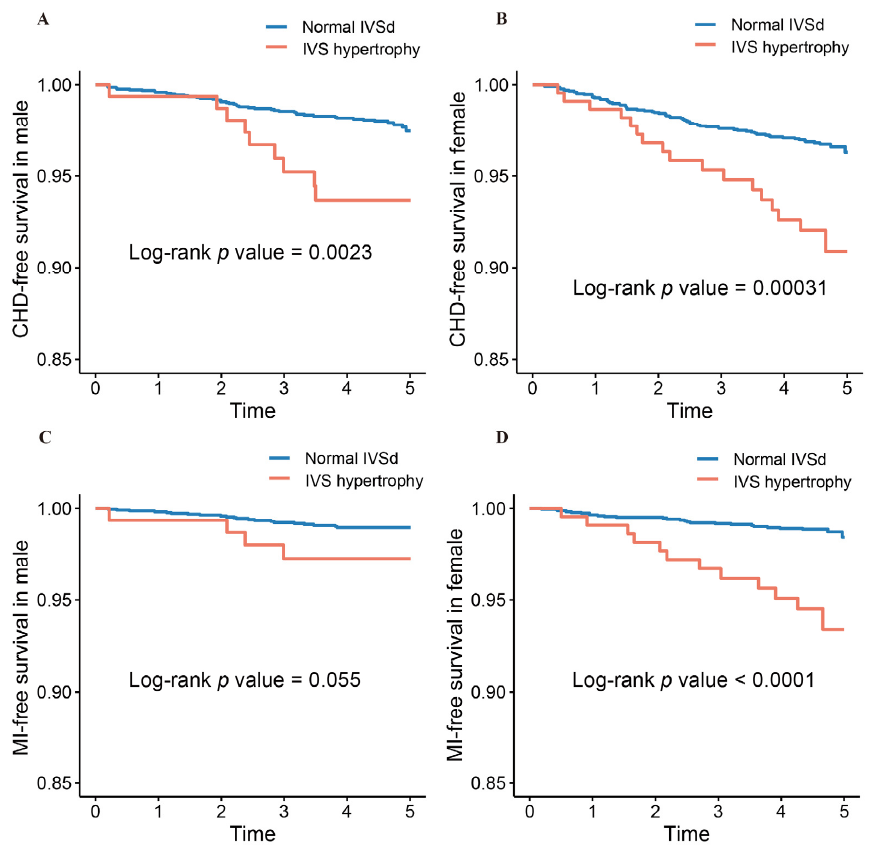
Figure 3. Kaplan–Meier survival curves for CHD-free survival in males ( A ) and females ( B ); MI-free survival in males ( C ) and females ( D ). CHD, coronary heart disease; MI, myocardial infarction; IVSd, interventricular septum thickness; IVS hypertrophy, interventricular septum hypertrophy. Table 3. IVS hypertrophy for the prediction of CHD, MI and stroke during follow up.